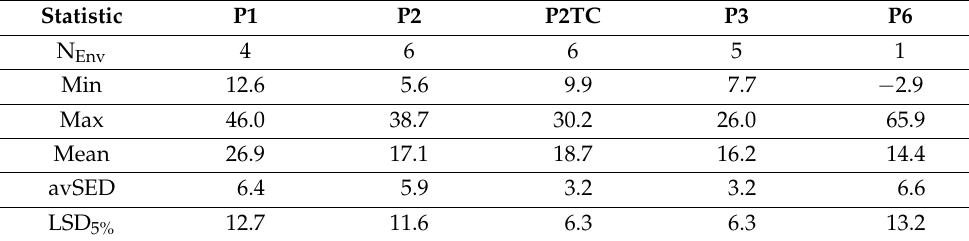
Table 7. Basic statistics for the different populations (columns) and leaf rust severity.